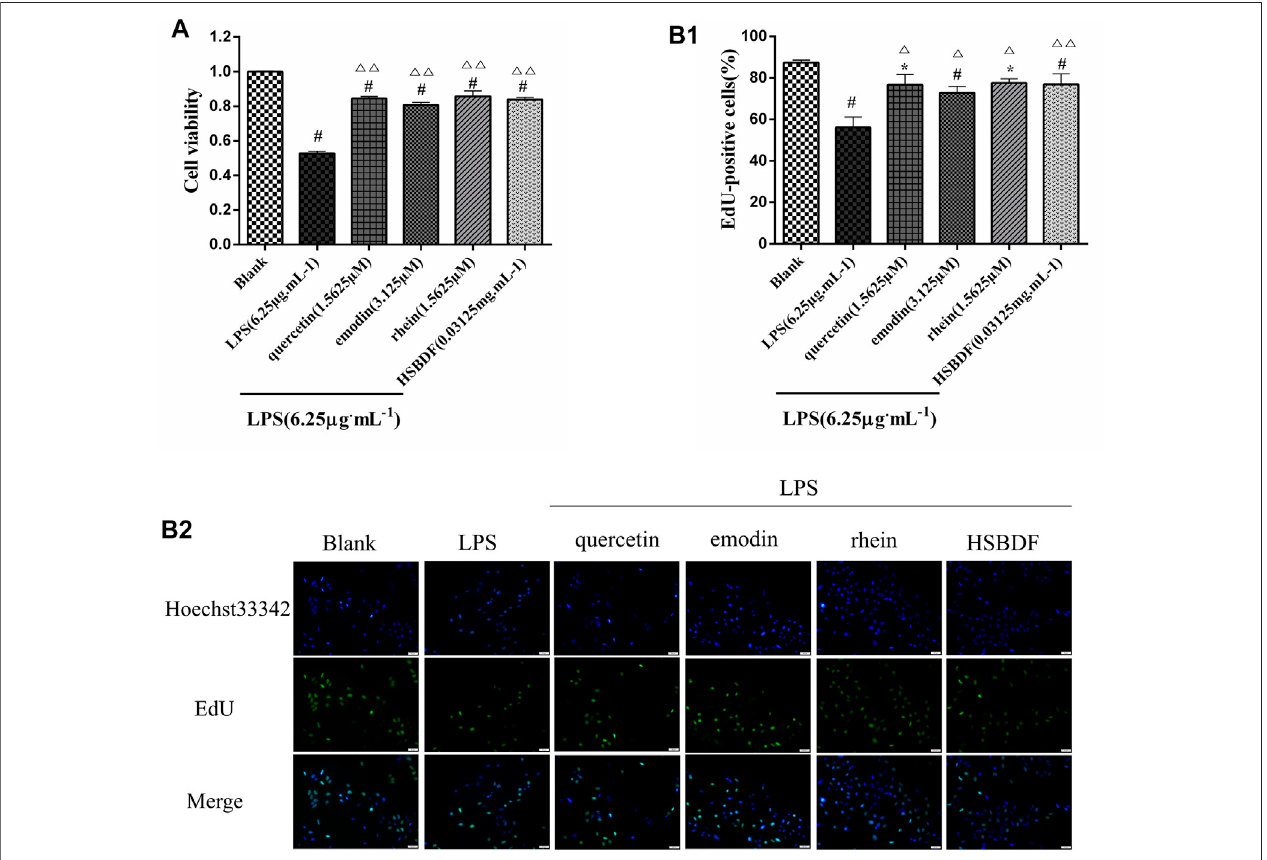
FIGURE 5 | Effect of HSBDF and active compounds treatment on cell proliferation in LPS-stimulated A549 cells. (A) Cell proliferation test by CCK-8; (B1,B2) DNA synthesis activity in cells examined by EdU staining (magni fi cation, x20) (* p < 0.05, # p < 0.01 versus blank; △ p < 0.05, △△ p < 0.01 versus LPS).